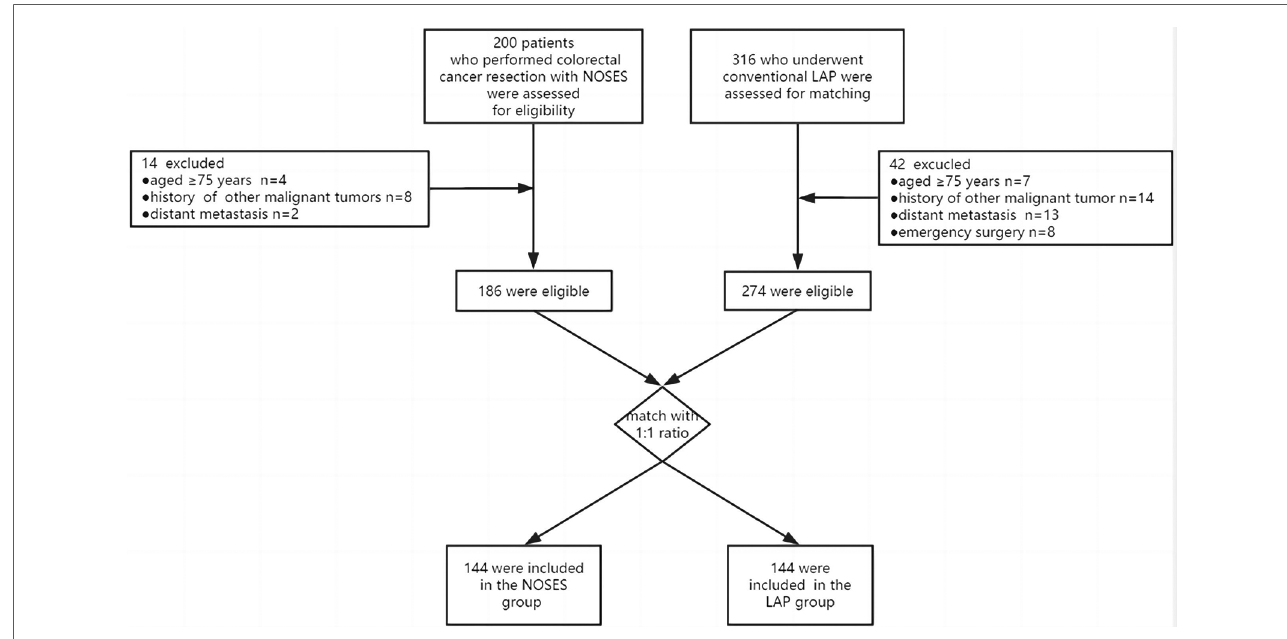
FIGURE 1 Patient selection fl